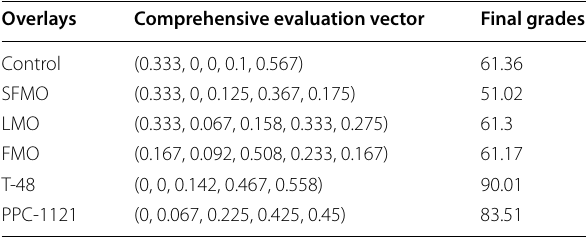
Table 10 Comprehensive evaluation vector and final grades of overlays in WA Overlays